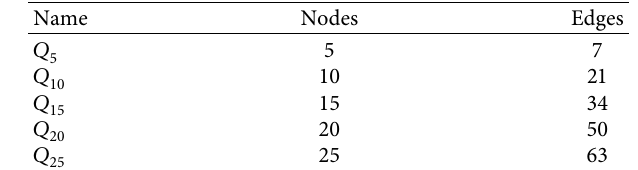
Table 1: The social datasets. Table 2: The pattern